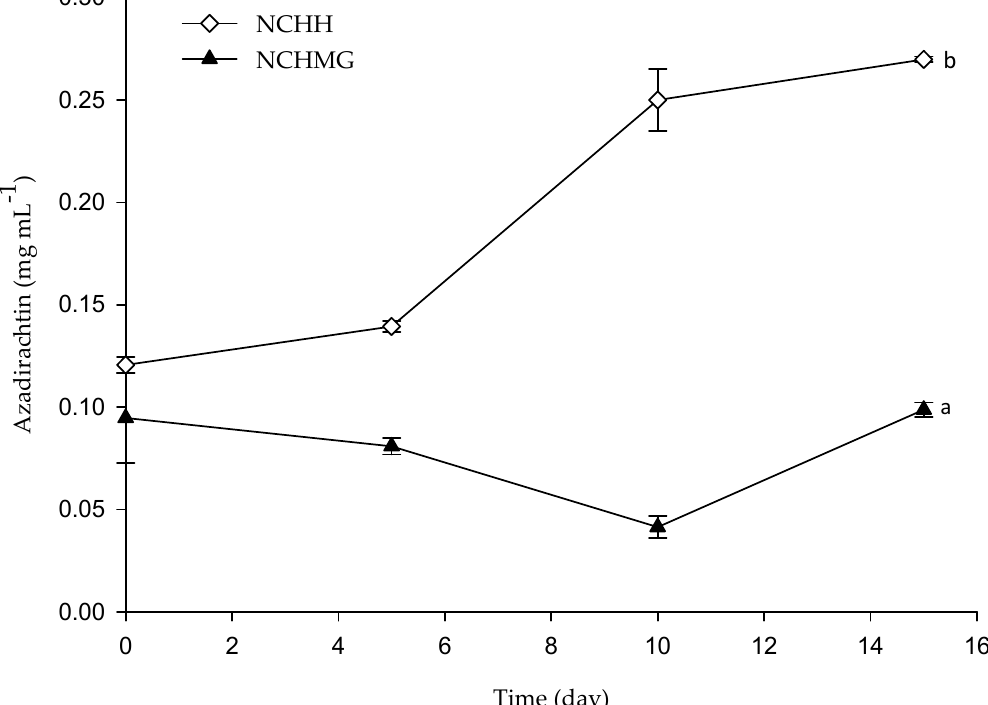
Figure 5. The release of azadirachtin of Neem during storage at 10 °C and relative humidity (RH) of 80 % . (See Table 2 for treatment identification). Data are the mean and their standard deviation ( n = 9). Different letters among traces mean significant differences ( p < 0.05).